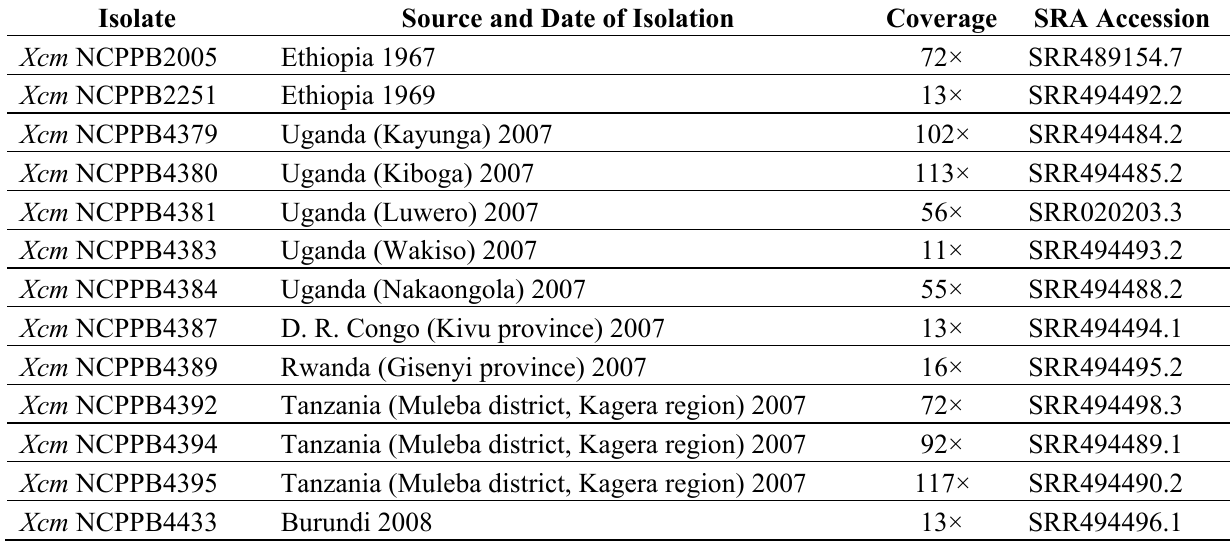
Table 1. Isolates of X. campestr is pv. musacearum ( Xcm) and X. vasicola pv. vasculorum ( Xvv) subjected to genome-wide sequencing. All Xcm isolates were originally collected from diseased banana plants except for NCPPB2005, which was isolated from Ensete ventricosum . All Xvv isolates were originally collected from sugarcane, except for NCPPB206, which was isolated from